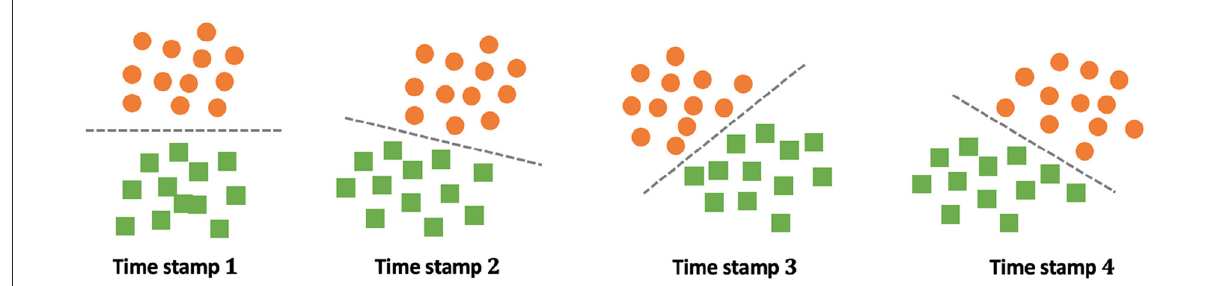
FIGURE2 Challenges of dynamic transfer learning where the task distribution is suddenly changed at time stamp 3. Here orange circle and green square denote data points from two classes, and the dashed line indicates the optimal decision boundary at different time stamps.